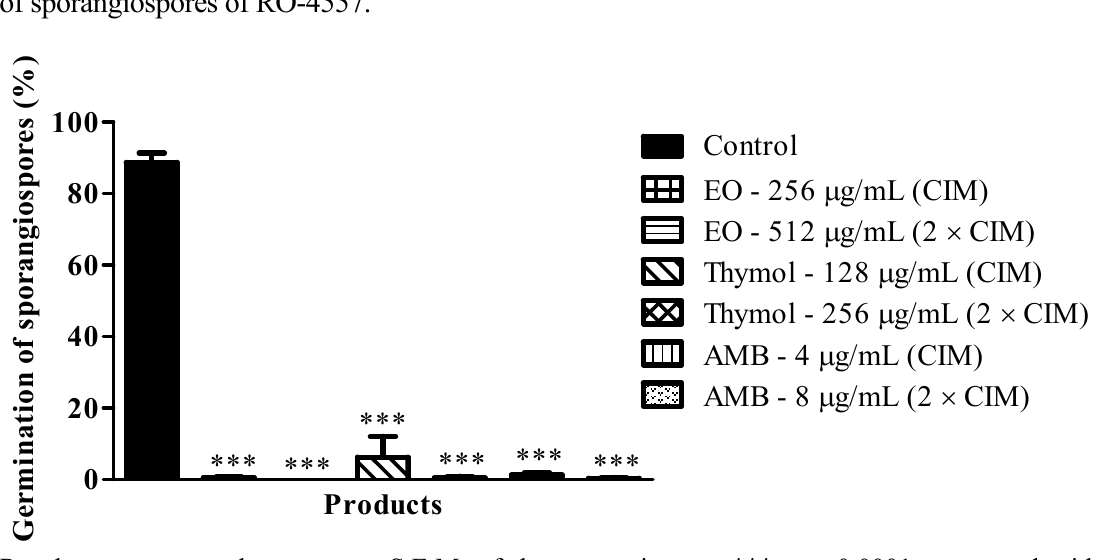
Figure 2. Effect of T. vulgaris essential oil, thymol and amphotericin B on the germination of sporangiospores of